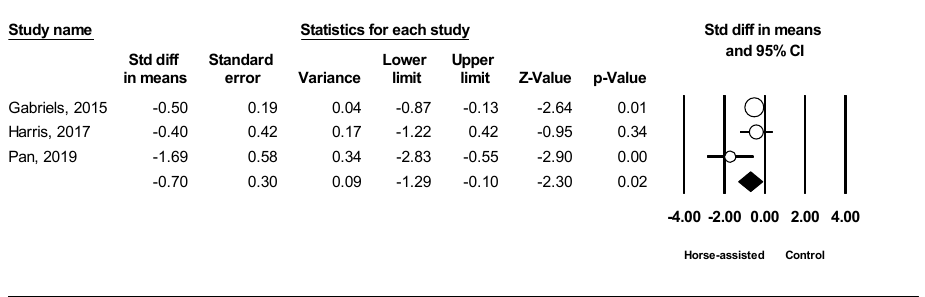
Figure 9. Forest plot showing the effects of horse-assisted therapy vs. control on hypersensitivity [44–46].